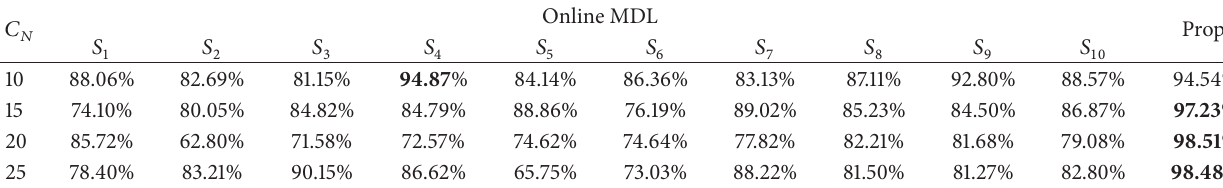
Table 3: Classification accuracy of 10 sensors.